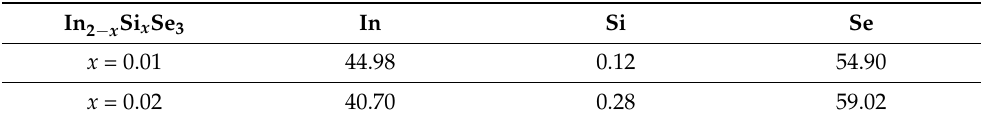
Table 1. Atomic percentage measured by energy-dispersive spectroscopy (EDS) for In 2 − x Si x Se 3 with x = 0.01 and